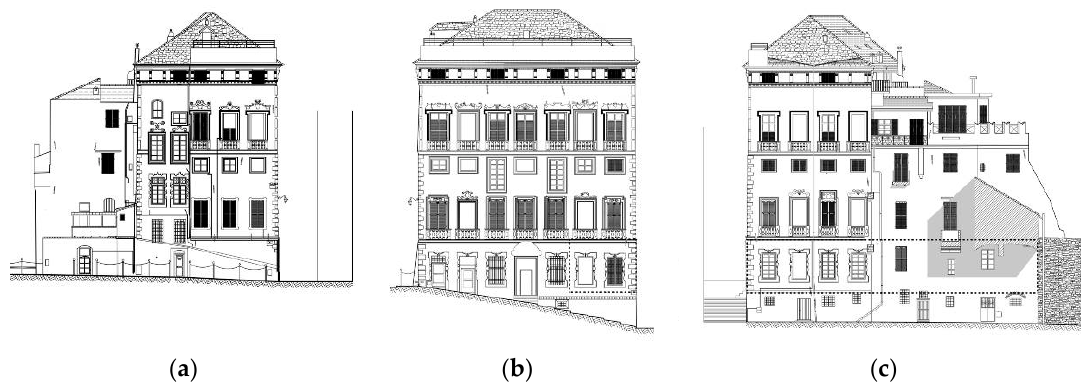
Figure 3. ( a ) East elevation of Palazzo Gastaldi-Lavagna, ( b ) north elevation and ( c ) west elevation.